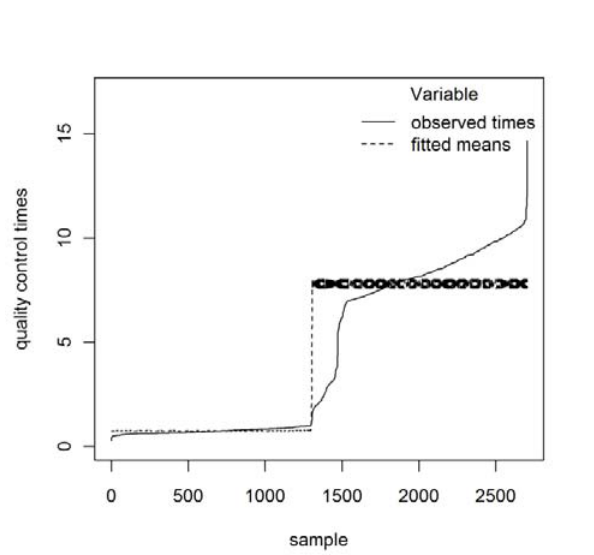
Fig. 3. Quality control times and fitted means versus samples (all data